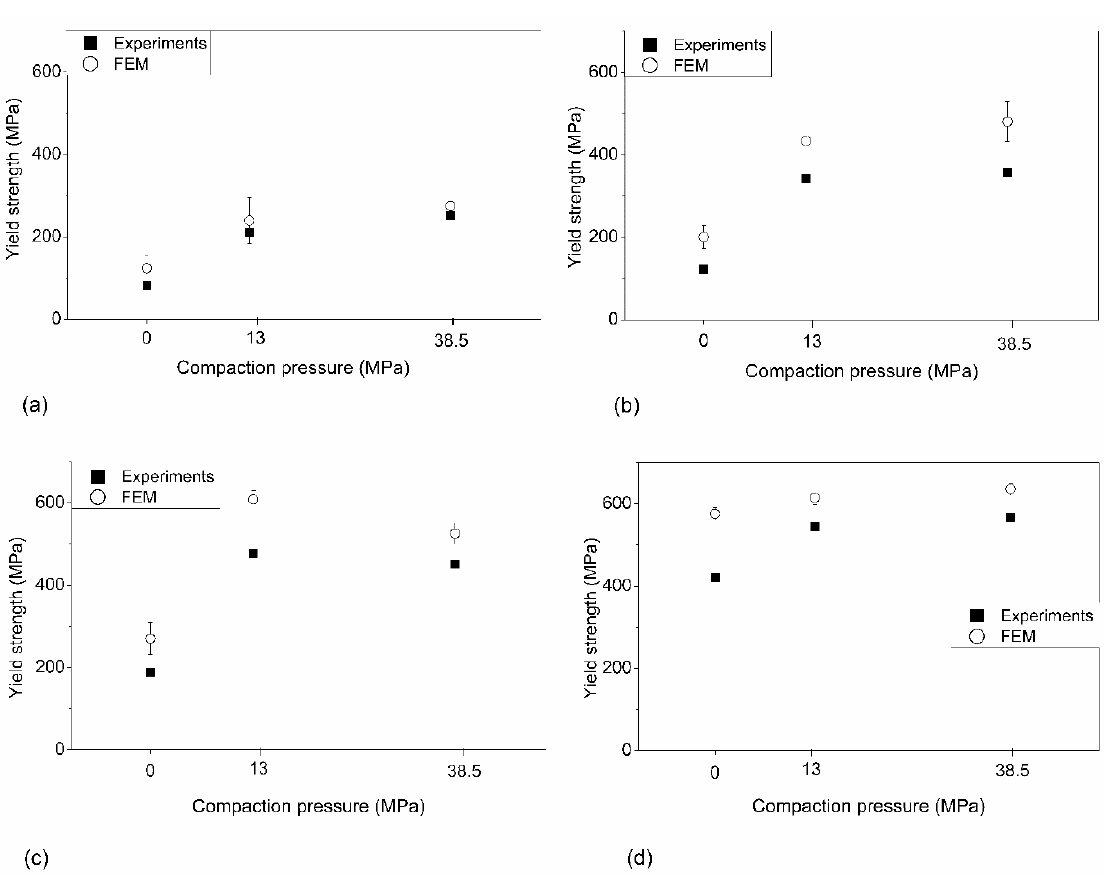
Figure 8. Experimental and simulated yield strength in terms of compaction pressure, for each sintering temperature: ( a ) 1000 °C; ( b ) 1100 °C; ( c ) 1200 °C; and ( d ) 1300 °C.